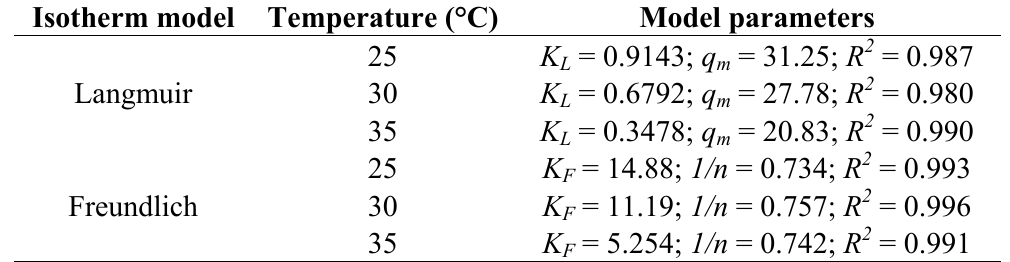
Table 1. Isotherm parameters for mogroside V adsorption on HZ 806 at different temperatures.